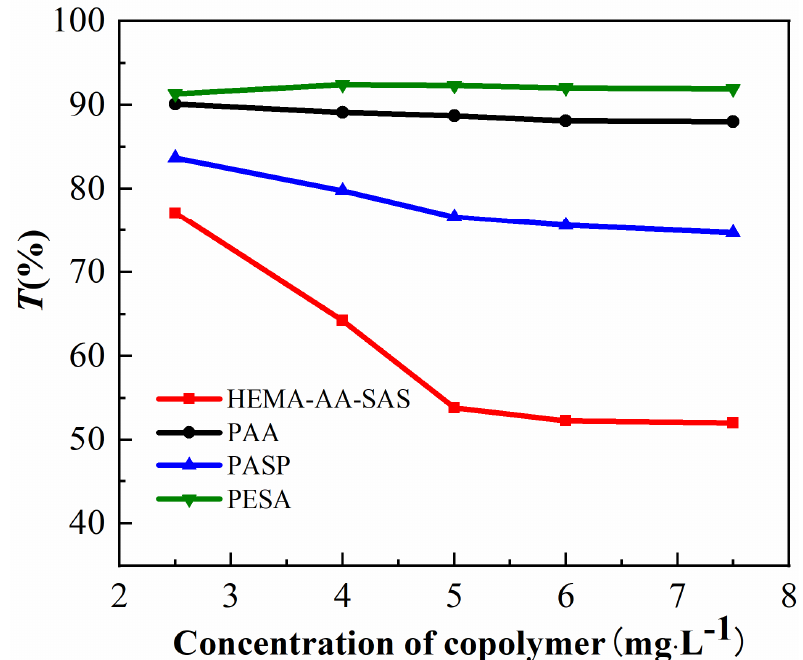
Figure 5. Influence of copolymer dosage on dispersibility iron performance